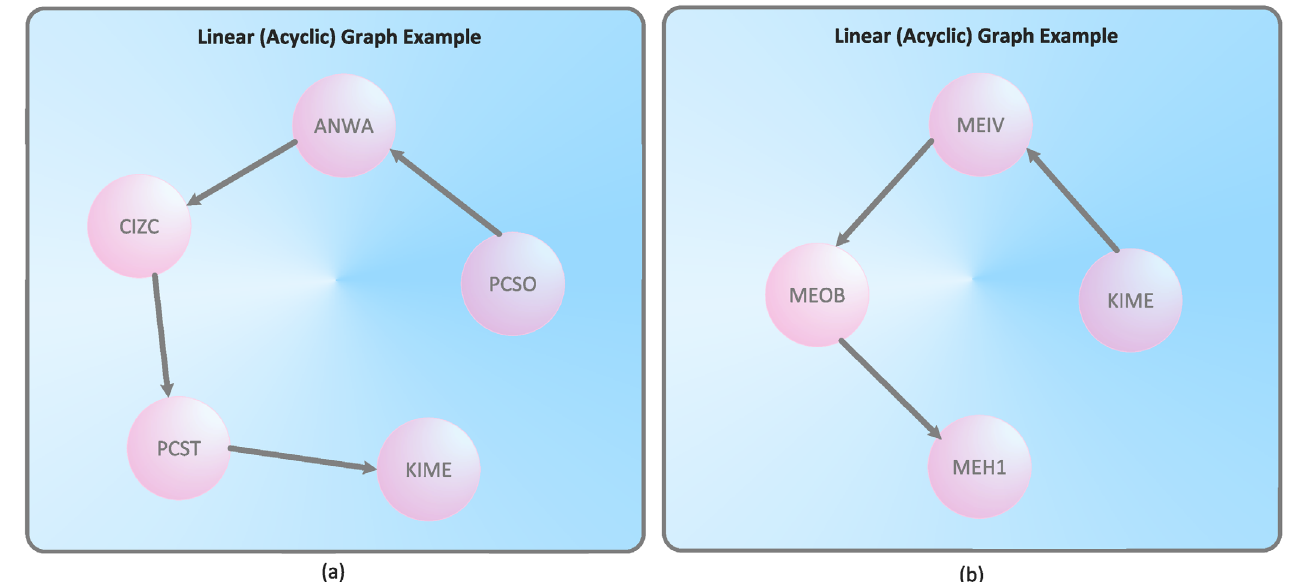
Fig 4. Examples of the linear (acyclic) treatment cycles.